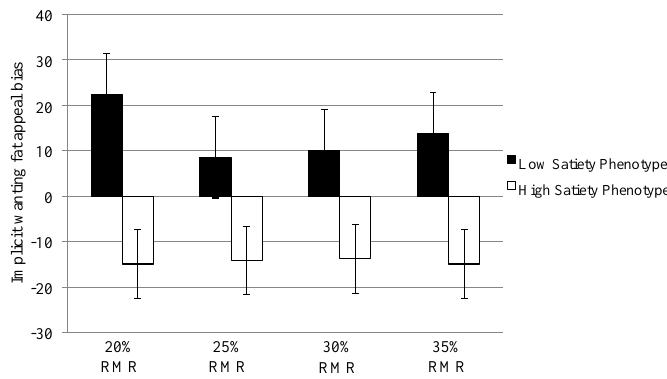
Figure 3. Implicit wanting fat appeal biases for the low and high satiety phenotype across the 20%, 25%, 30% and 35% resting metabolic rate (RMR) conditions. A positive value indicates a bias towards high-fat foods.